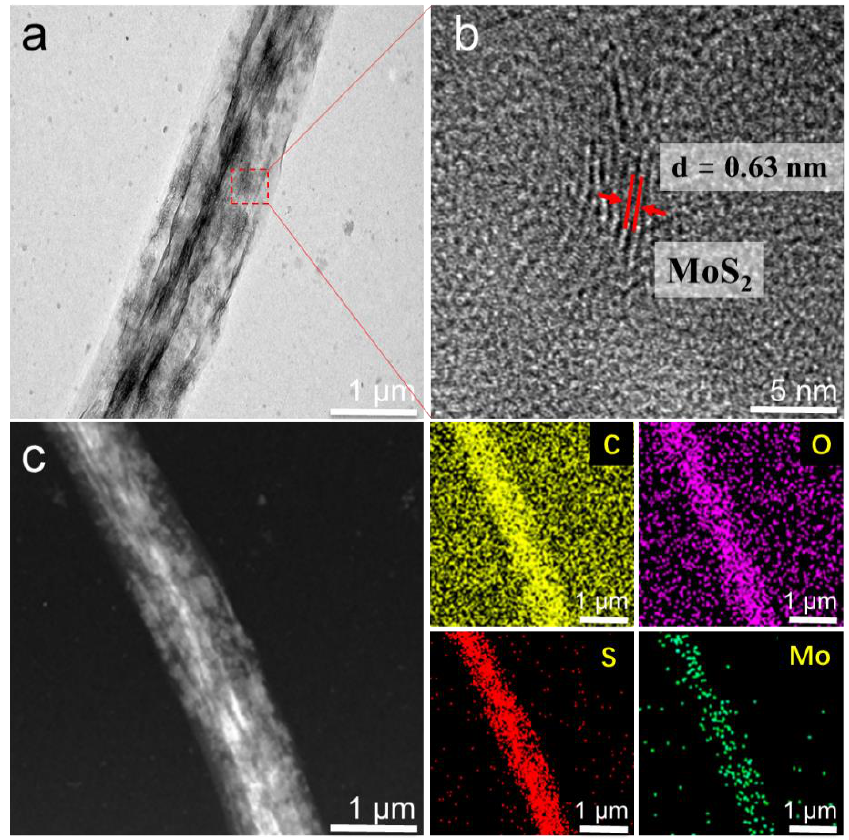
Figure 3. ( a ) The TEM image of the MoS 2 @RGO nanoscroll. ( b ) HRTEM image of the MoS 2 nanosheets marked by the dashed box shown in ( a ). ( c ) The STEM image and EDX elemental mapping of the MoS 2 @RGO nanoscroll.